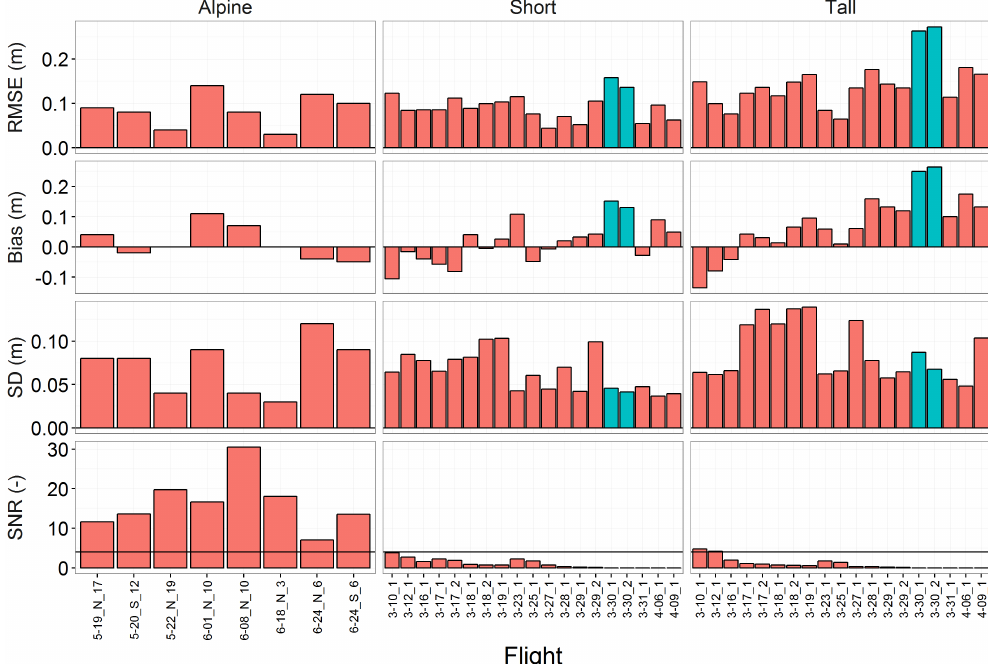
Figure 5. Estimated UAV snow depth error with respect to observed snow depth at the alpine site and the short and tall stubble treatments at the prairie site. Blue bars highlight problematic flights and are excluded from summarization in Table 3. The x axis labels represent month– day. The last number in prairie labels is the flight of the day (to separate flights that occurred on the same day). Alpine labels separate the northern or southern flight areas suffixed as N or S, respectively, and the last value is the number of observations used to assess accuracy as they vary between 3 and 19. Horizontal line in the SNR plots is the Rose criterion (SNR ≥ 4) that is used to identify flights with a meaningful snow depth signal.